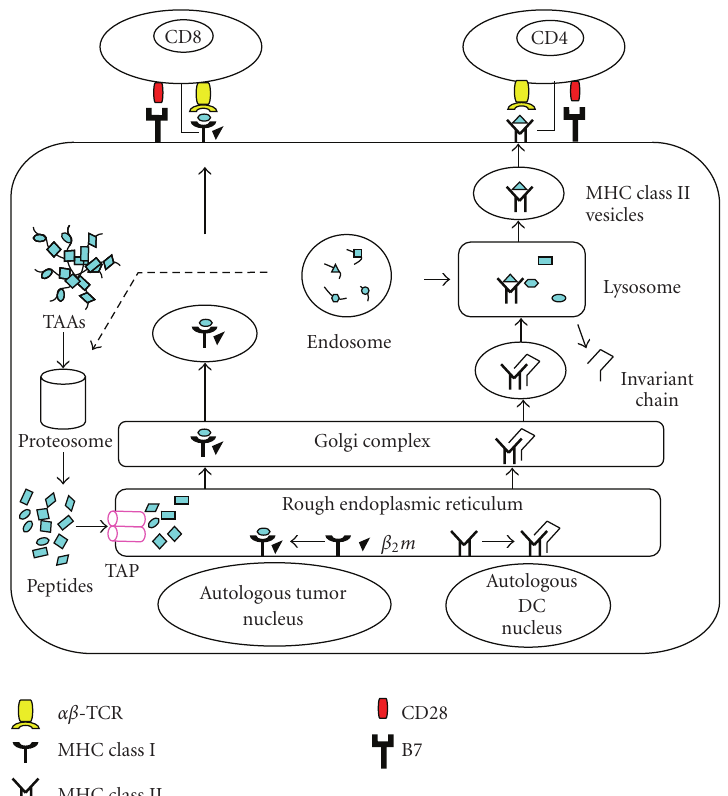
Figure 1: Fusions of autologous DCs and autologous tumor cells. The DCs/tumor fusion cells express MHC class I and class II and costimulatory molecules as well as tumor-associated antigens. The fusions are able to process tumor-derived peptides and MHC class I peptides derived from DCs. They form MHC class I-peptide complexes, in the endoplasmic reticulum, which are transported to the surface and presented to CD8+ T cells. Similarly, the fusion cells can also synthesize MHC class II peptides derived from DCs in the endoplasmic reticulum, which are transported to the cytoplasm where MHC class II-peptide complexes are assembled with tumor-derived peptides. These complexes are presented to CD4+ T cells, which are important for e ffi cient CTL